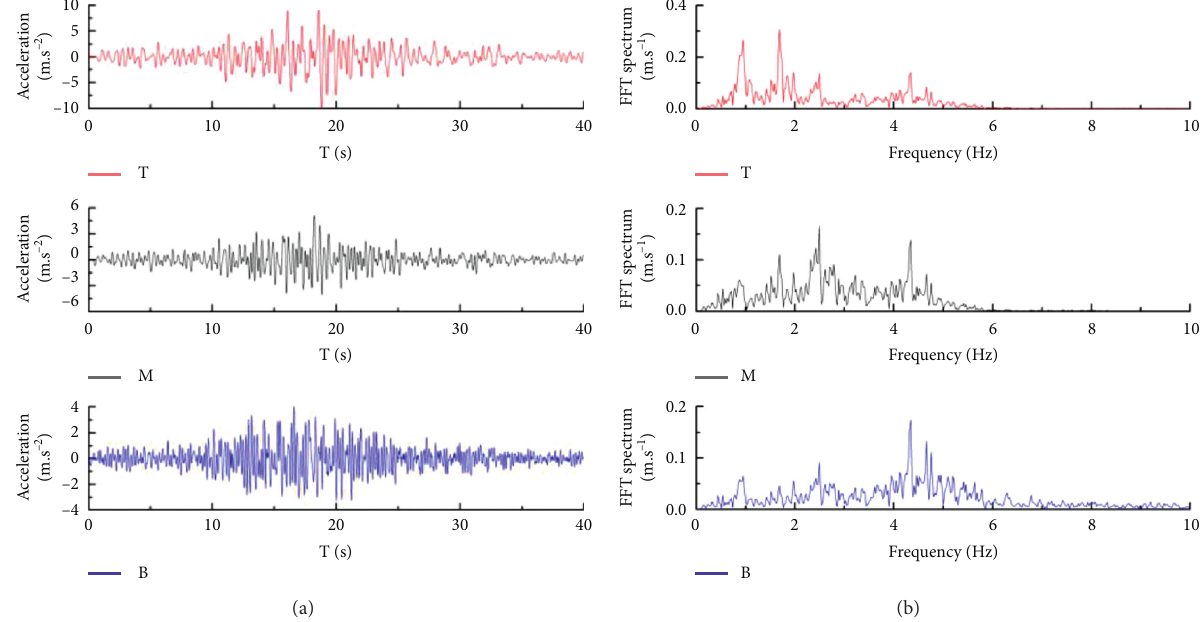
Figure 14: Ground motion characteristics under Tianshui seismic excitation: (a) acceleration time histories and (b) spectrum